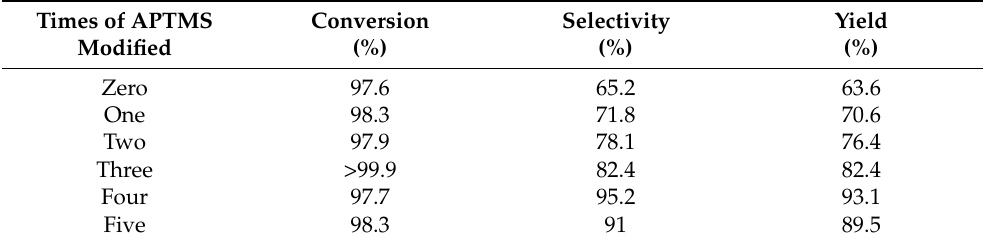
Table 3. The PO conversion, PC selectivity, and PC yield using the APTMS-modified Zr–Mg mixed oxide aerogels with Zr/Mg molar ratio of 7/3 under different modification times at a reaction tem- perature of 150 °C.